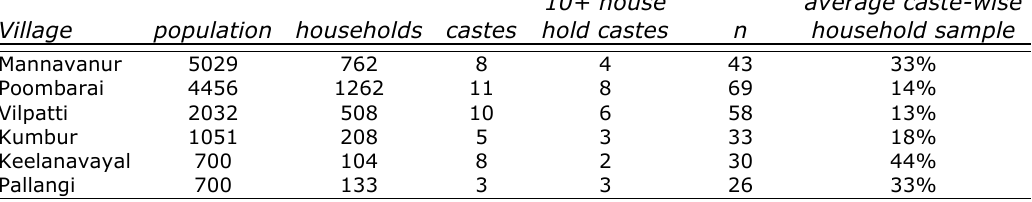
Table A 2. Sampling strategy.